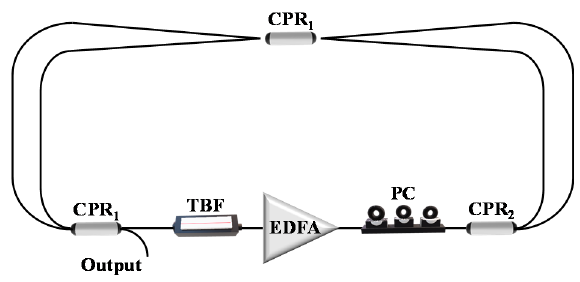
Figure 1. Experimental setup of demonstrated EDF laser architecture.